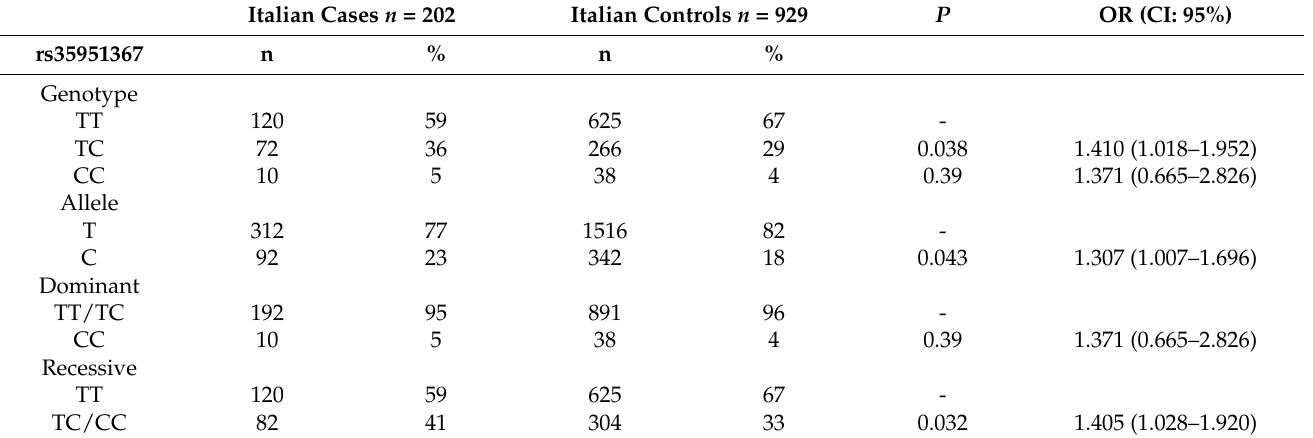
Table 1. Association of common regulatory variant rs35951367 with severe COVID-19 in the Italian cohort. Italian Cases n = 202 Italian Controls n =